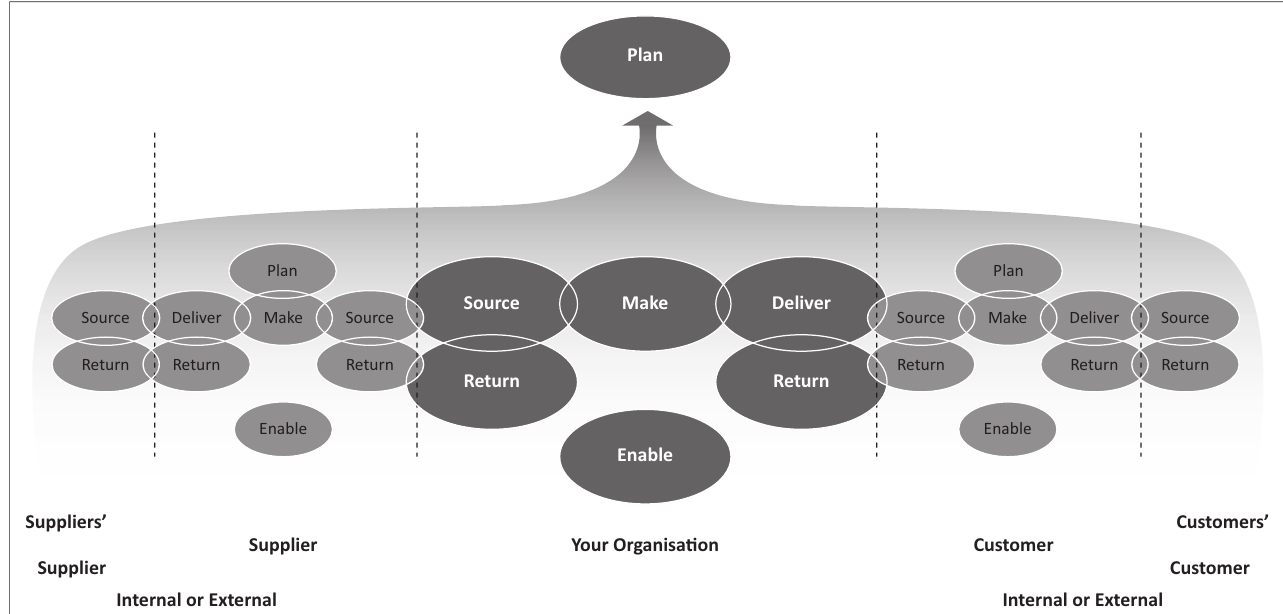
FIGURE 1: Six major supply chain management processes of Supply Chain Operations